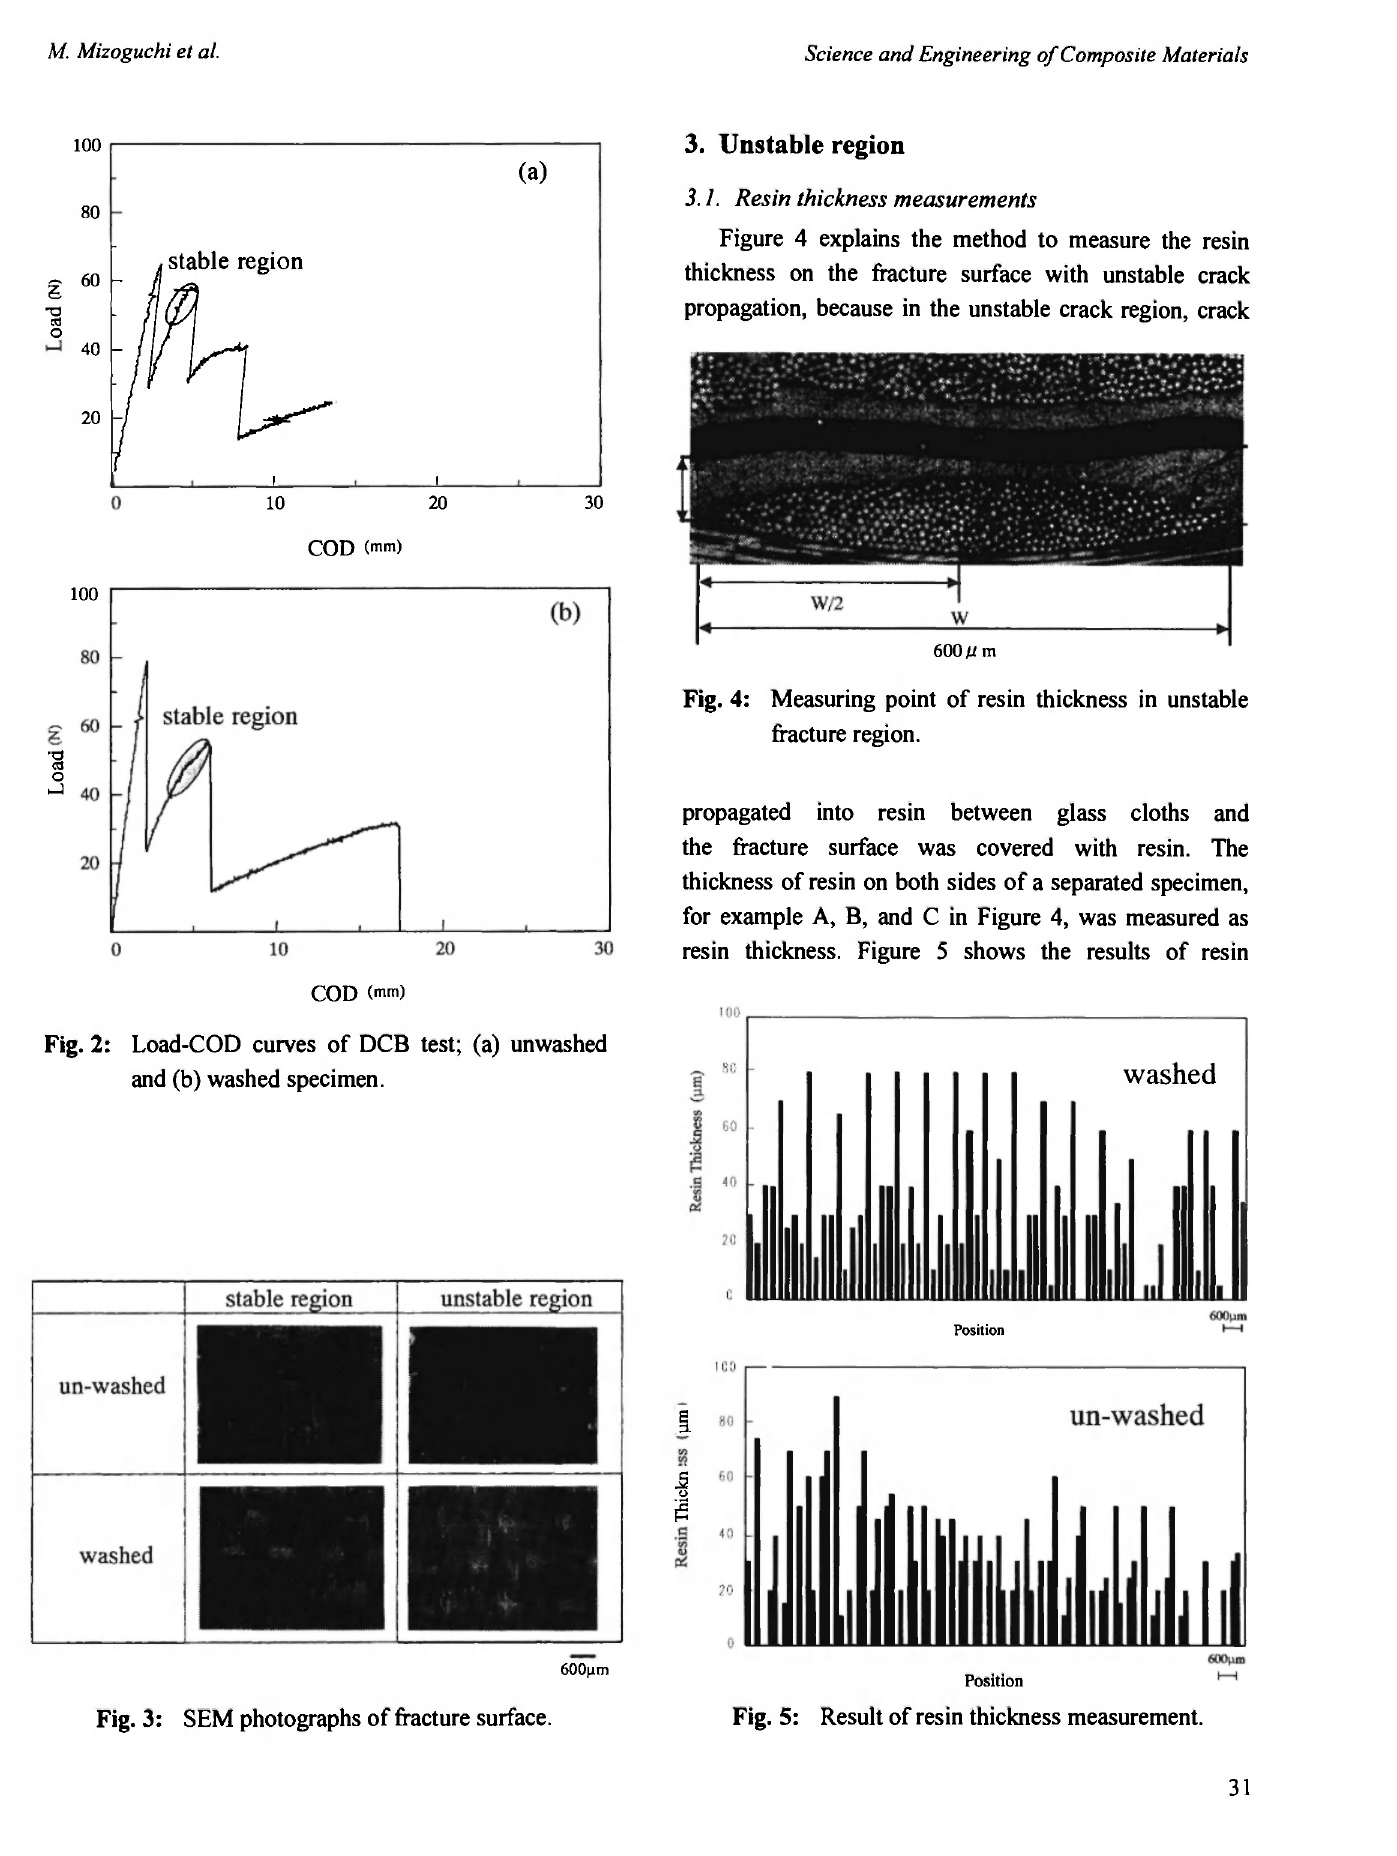
Fig. 3: SEM photographs of fracture surface. Fig. 5: Result of resin thickness